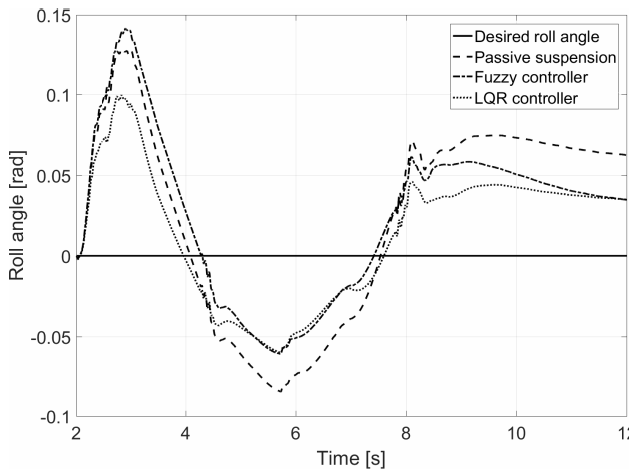
Figure 19. Roll angle for Test 3.